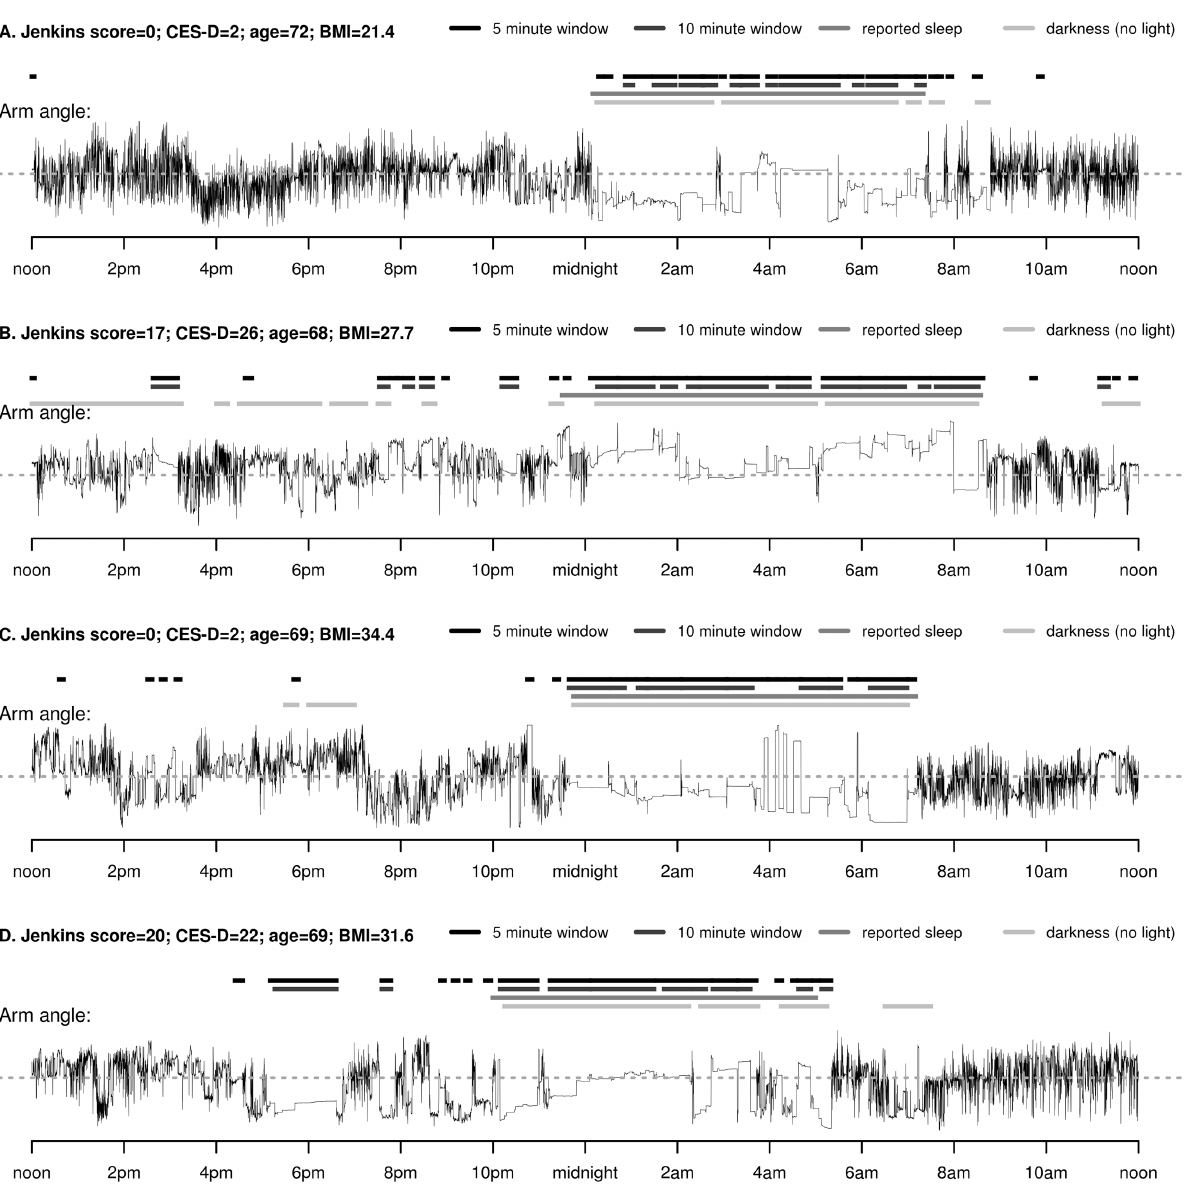
Fig 1. Example of arm angle, detected sustained inactivity bouts, reported sleep and detected darkness from light sensor from the wrist monitor in four participants with distinct individual characteristics (A-D), all on a Thursday evening.